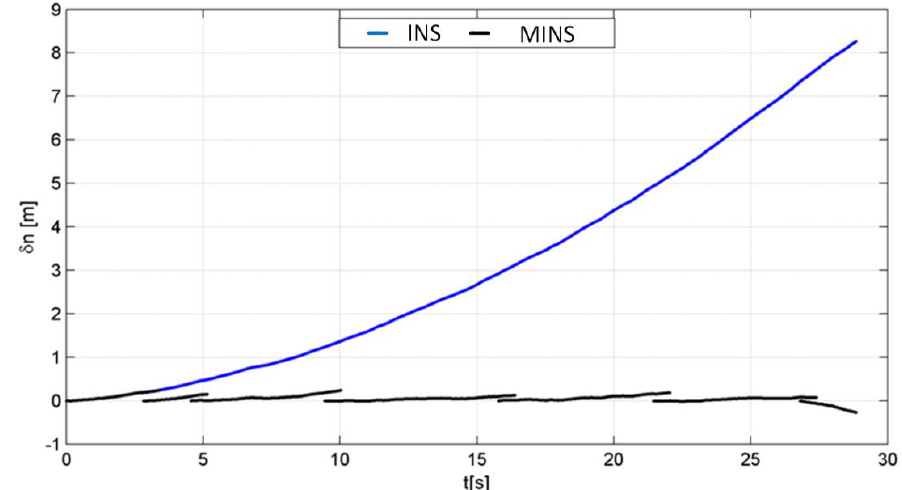
Figure 6. INS (blue) and MINS (black) position error with respect to the INS/GPS trajectory, North axis.